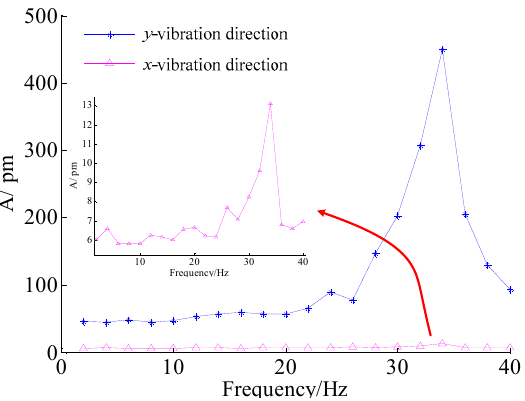
Figure 9. Amplitude-frequency curve of the FBG micro-vibration sensors in the x and y -direction.